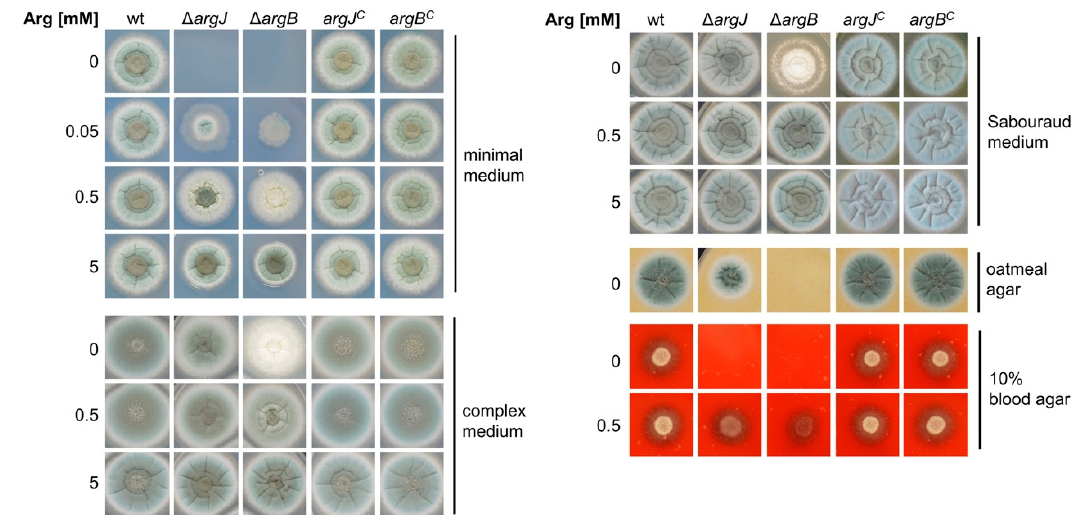
Figure 2. Deletion of argJ and argB leads to arginine auxotrophy in A. fumigatus. Wild-type (wt), mutant ( ∆ argJ and ∆ argB ), and complemented ( argJ C and argB C ) strains were point inoculated (1 × 10 4 conidia) on minimal medium (AMM), complex medium (CM), Sabouraud medium, oatmeal medium, or 10% blood agar containing increasing arginine concentrations and grown at 37 °C for 48 h. Green coloration of the colony reflects sporulation due to green pigmentation of spores.